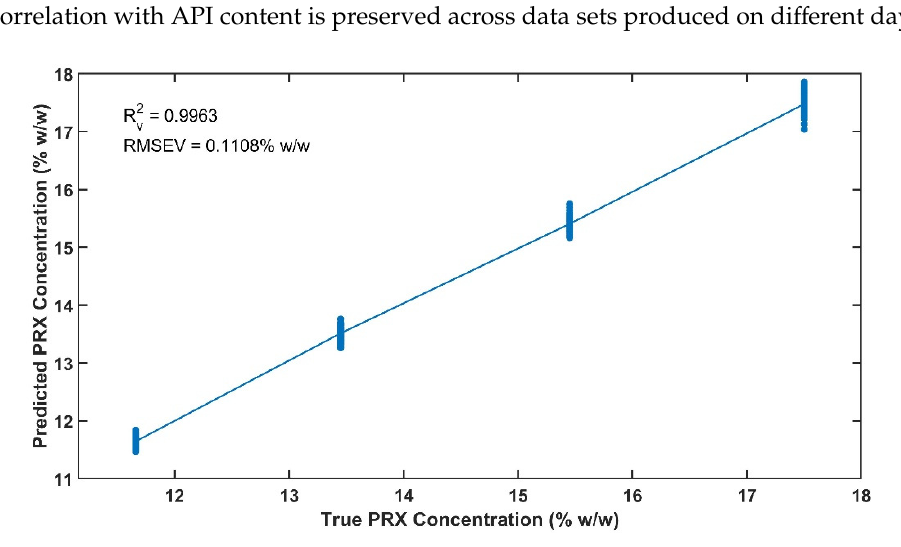
Figure 12. Linearity of the validation data set.